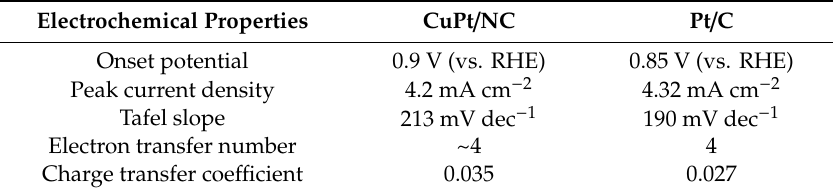
Table 2. Comparison of ORR performance for CuPt / NC and commercial Pt /